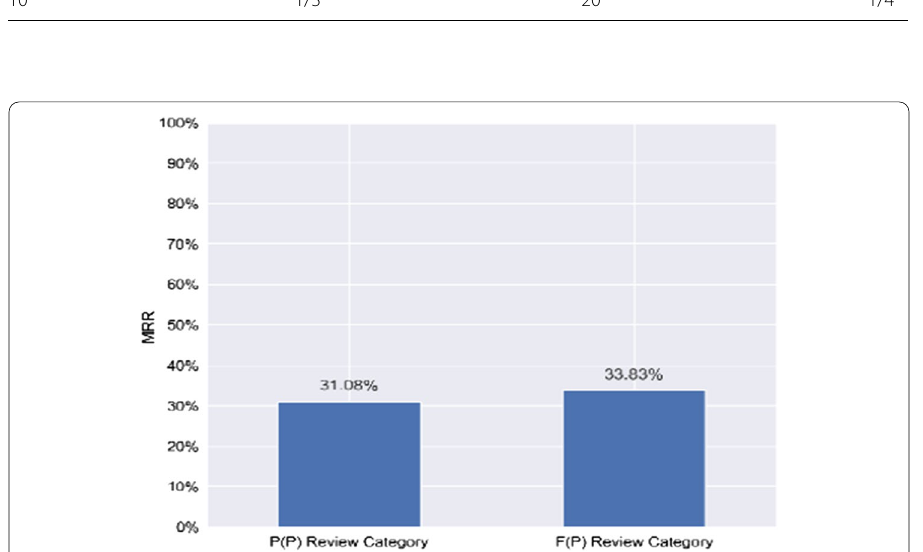
Fig. 11 New users calculate popularity and friend popularity based on A ( p